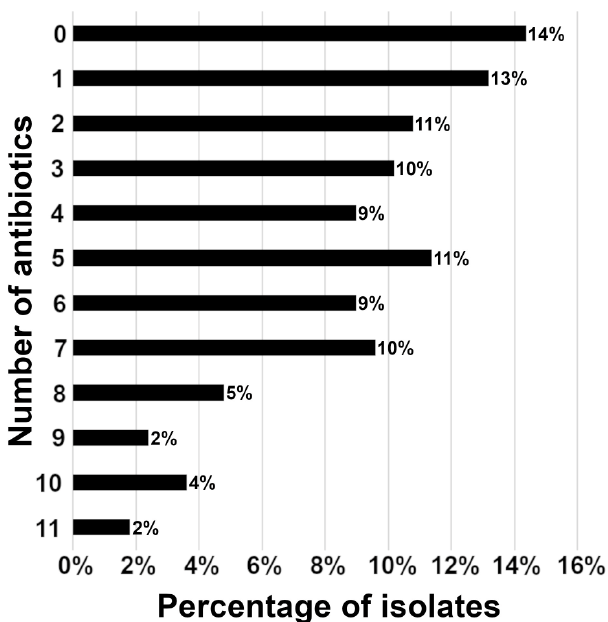
Figure 4. Distribution of resistant isolates against multiple antibiotics. Percentage of the isolates that are resistant to the corresponding number of antibiotics. Bacterial samples were isolated from canine corneal stromal ulcers (number of isolates = 167).